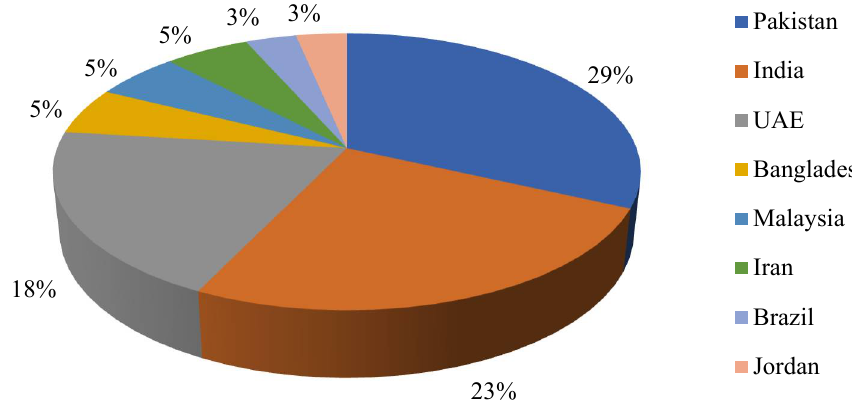
Figure 2. Geographical distribution of responses.